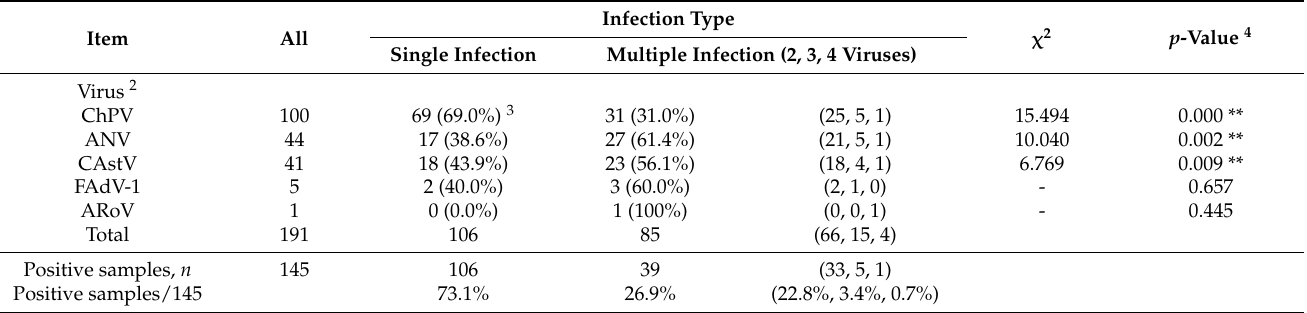
Table 4. Frequencies of viruses and samples in single and multiple viral infections diagnosed 1 .